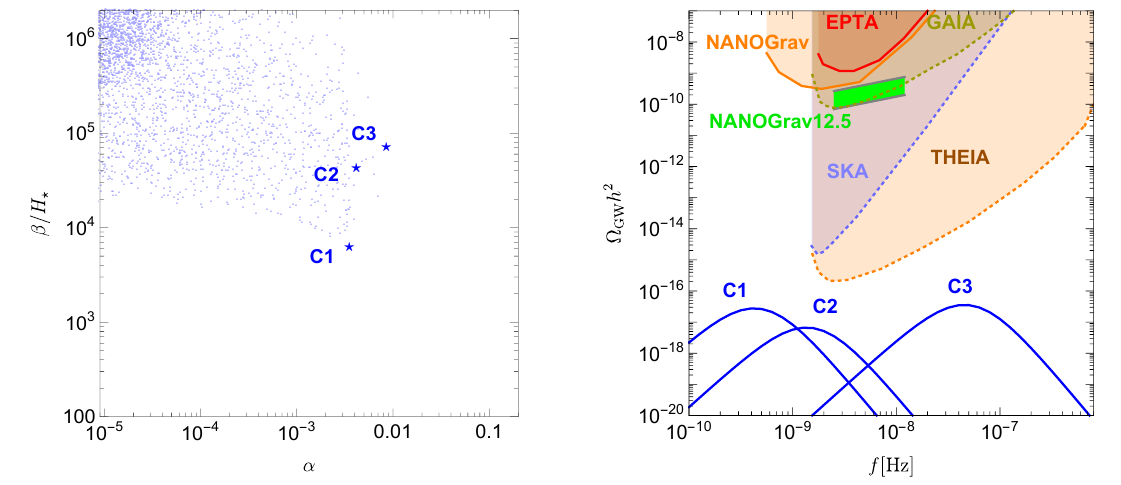
Figure 4 . Low scale scenario for T dec & 100 GeV and T ? . 100 keV . Left panel: scatter plot in the ( α, β/H ) plane. Right panel: GW spectra for the three benchmark points in table 3 and marked ? with stars in the left panel.